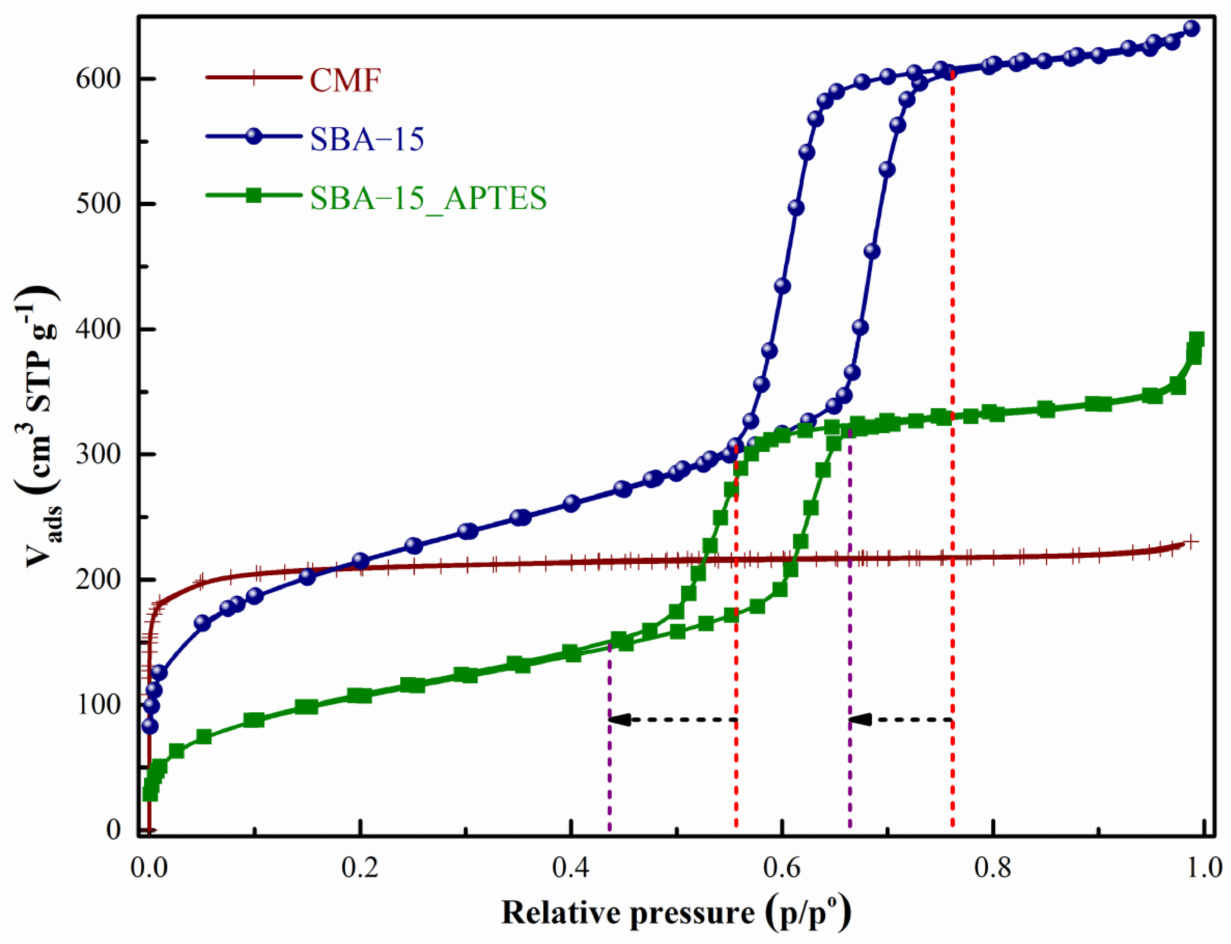
Figure 4. Nitrogen adsorption/desorption of micro-mesoporous